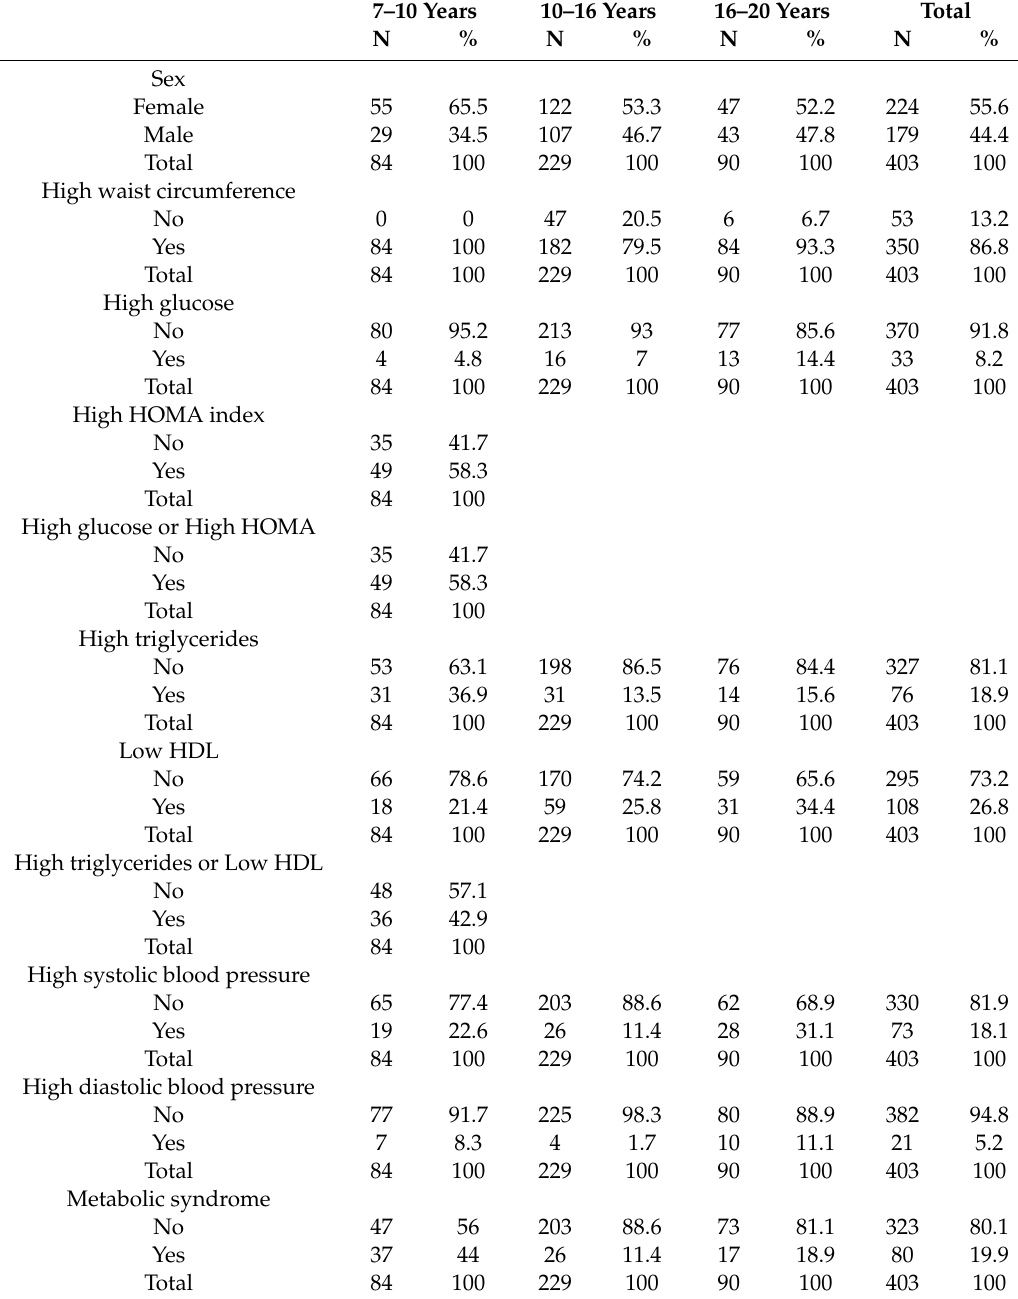
Table 2. Distribution of metabolic syndrome and its components according to age